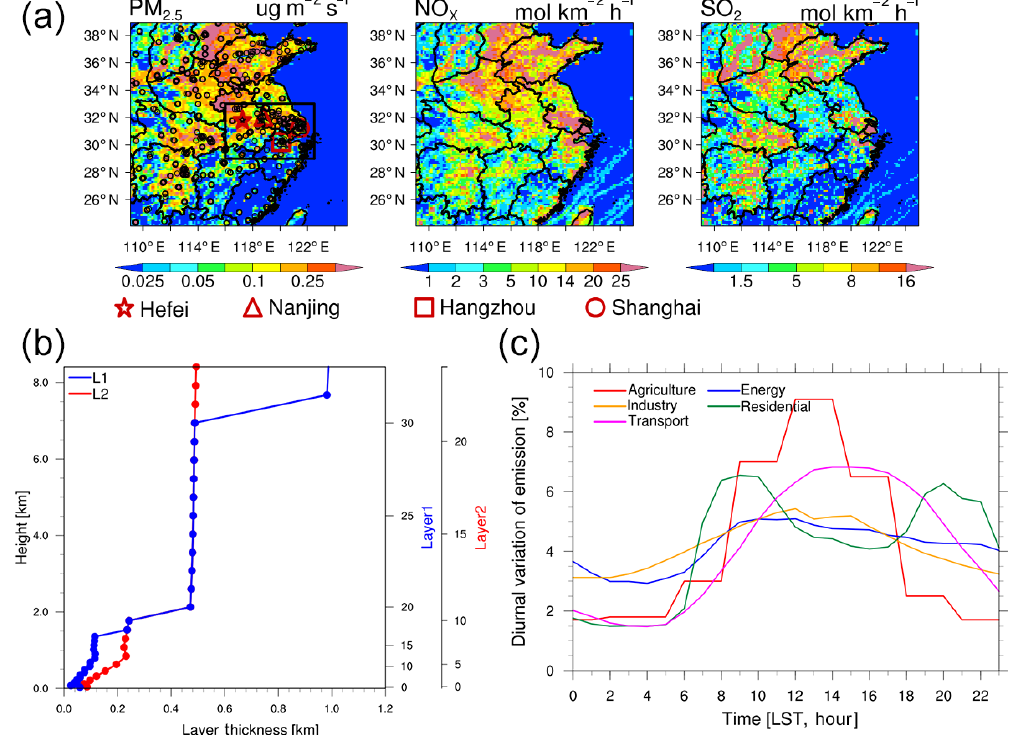
Figure 1. (a) Emissions of SO 2 , NO 2 , and PM 2 . 5 from the MEIC China inventory over the simulation domain (109.0–124.9 ◦ E, 24.0– 38.9 ◦ N) with black boxes showing the analyzed domain (116.0–122.5 ◦ E, 29.0–33.0 ◦ N), overlaid with observational sites and four cities as the center (Shanghai, 121.45 ◦ E and 31.21 ◦ N) and sub-center (Nanjing, 118.78 ◦ E and 32.06 ◦ N; Hefei, 117.25 ◦ E and 31.85 ◦ N; Hangzhou, 120.08 ◦ E and 30.21 ◦ N) of the YRD city cluster. (b) Vertical profiles of the layer thickness from L1 and L2 layer configuration. (c) Diurnal profiles of emissions from five individual sectors (agriculture, industry, transport, energy, and